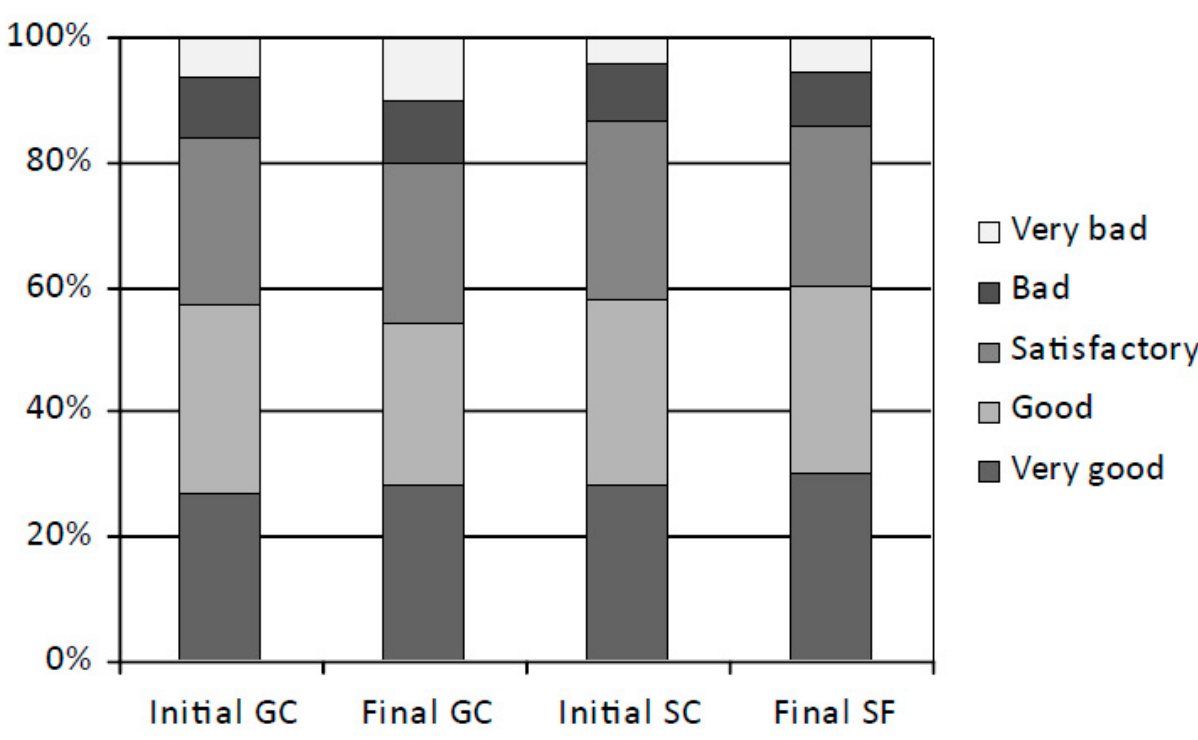
Figure 1. Comparison of eating behaviour between the initial (2017) and the final (2019) assessment sessions, %. GC—control group of standard PA at school (4 h a week); SC–increased PA at school (10 h a week).